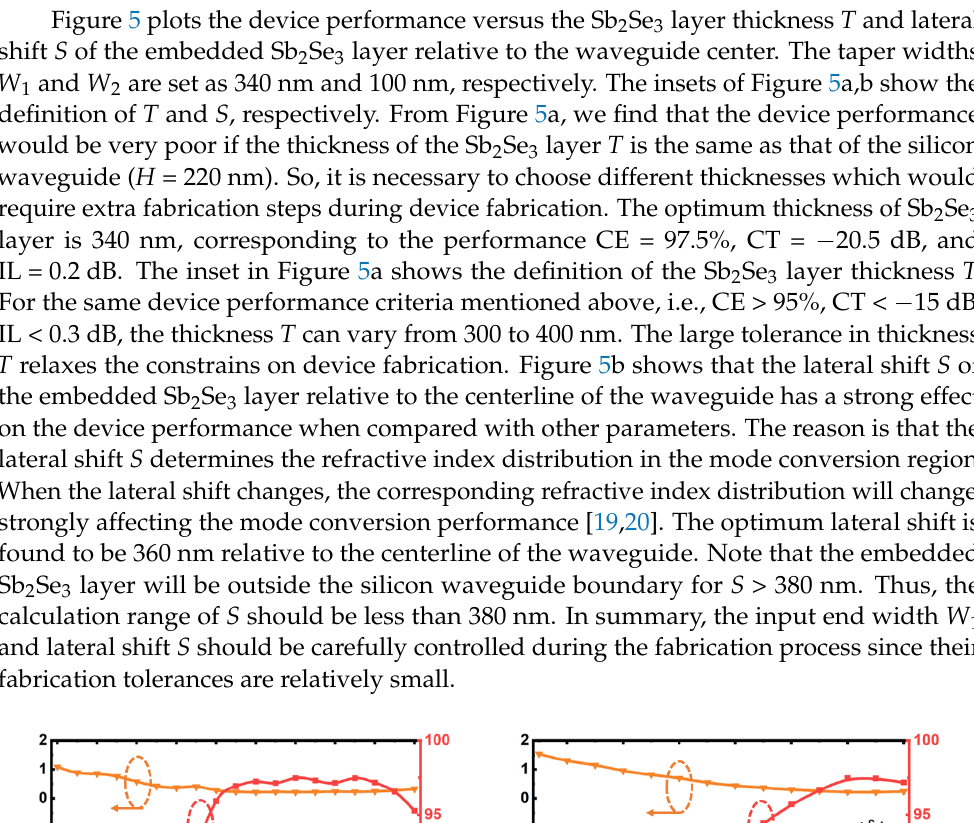
Figure 4. Device performance (mode CE, CT, and IL) as functions of the ( a ) input end width W 1 and ( b ) output end width W 2 of the embedded Sb 2 Se 3 layer for the proposed mode converter. Insets show the definition of the device parameters being calculated.